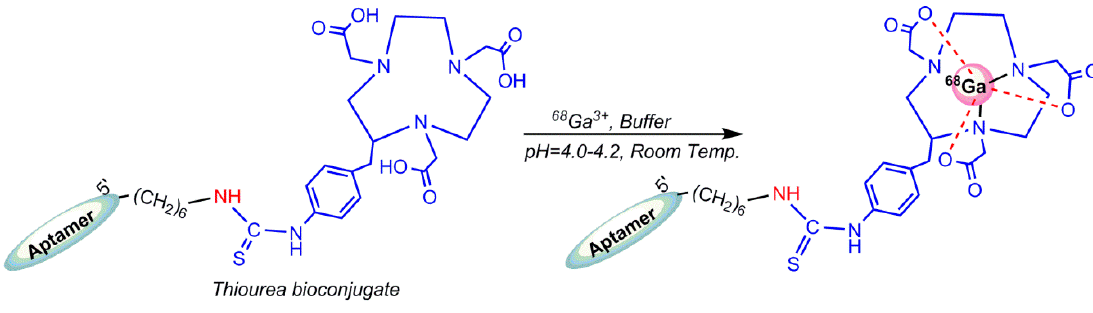
Figure 21. 68 Ga ‐ radiolabeling of Thiourea–NOTA–aptamer. Figure 21. 68 Ga-radiolabeling of